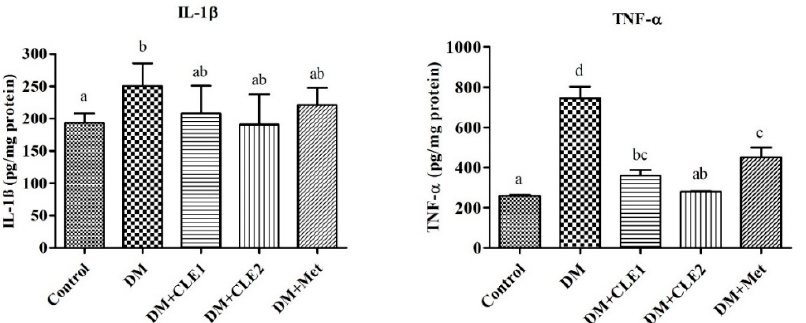
Figure 5. The levels of IL-1 β and TNF- α in diabetic mice after treatment for 6 weeks. Data are shown as mean ± SD ( n = 5). The values with different letters (a–d) represent significant difference ( p < 0.05) as analyzed by a Duncan’s multiple range test. IL-1 β , interleukin-1 β ; TNF- α , tumor necrosis factor- α ; DM, diabetes; DM + CLE1, diabetes and 600 mg / kg of C. lentillifera ; DM + CLE2, diabetes and 1000 mg / kg of C. lentillifera ; DM + Met, diabetes and 200 mg / kg of metformin; IL-1 β , interleukin-1 beta; TNF- α , tumor necrosis factor-alpha.